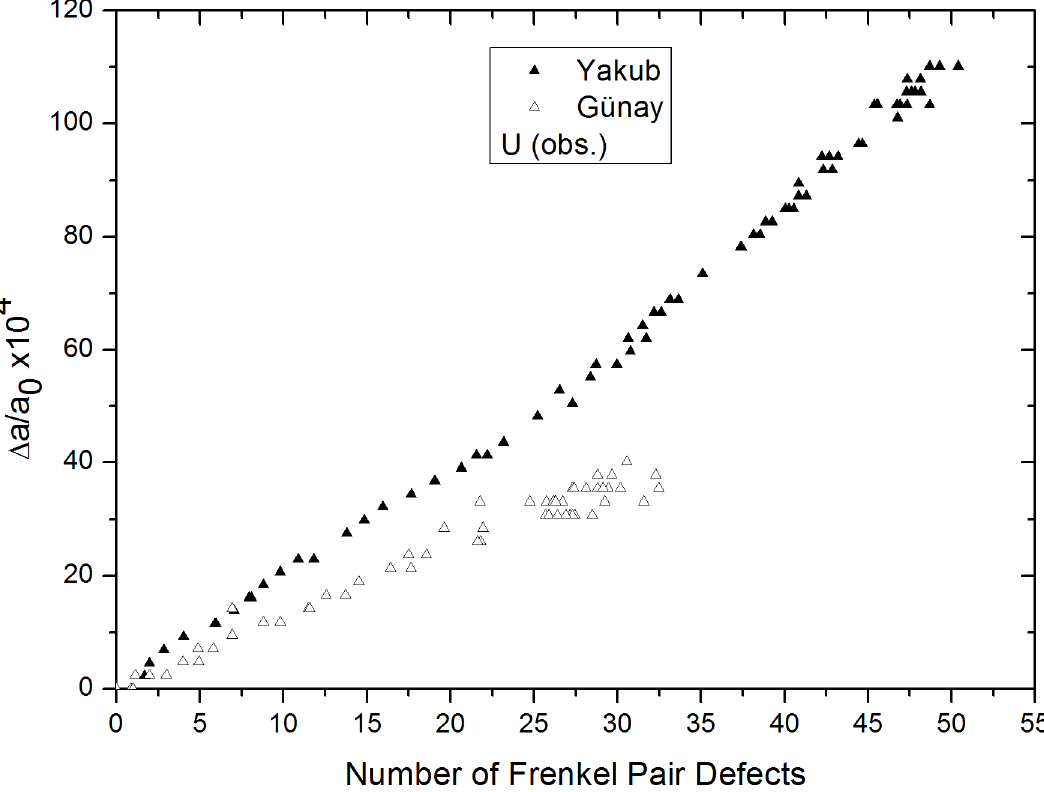
Fig 10. Relative lattice expansion versus number of obstruction type uranium defects, from Yakub and Günay potentials.